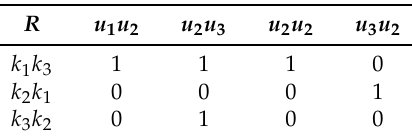
Table 3. Soft relation R